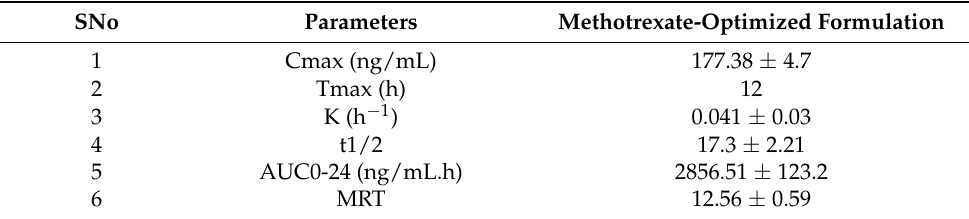
Table 5. Pharmacokinetic analysis of the optimized formulation